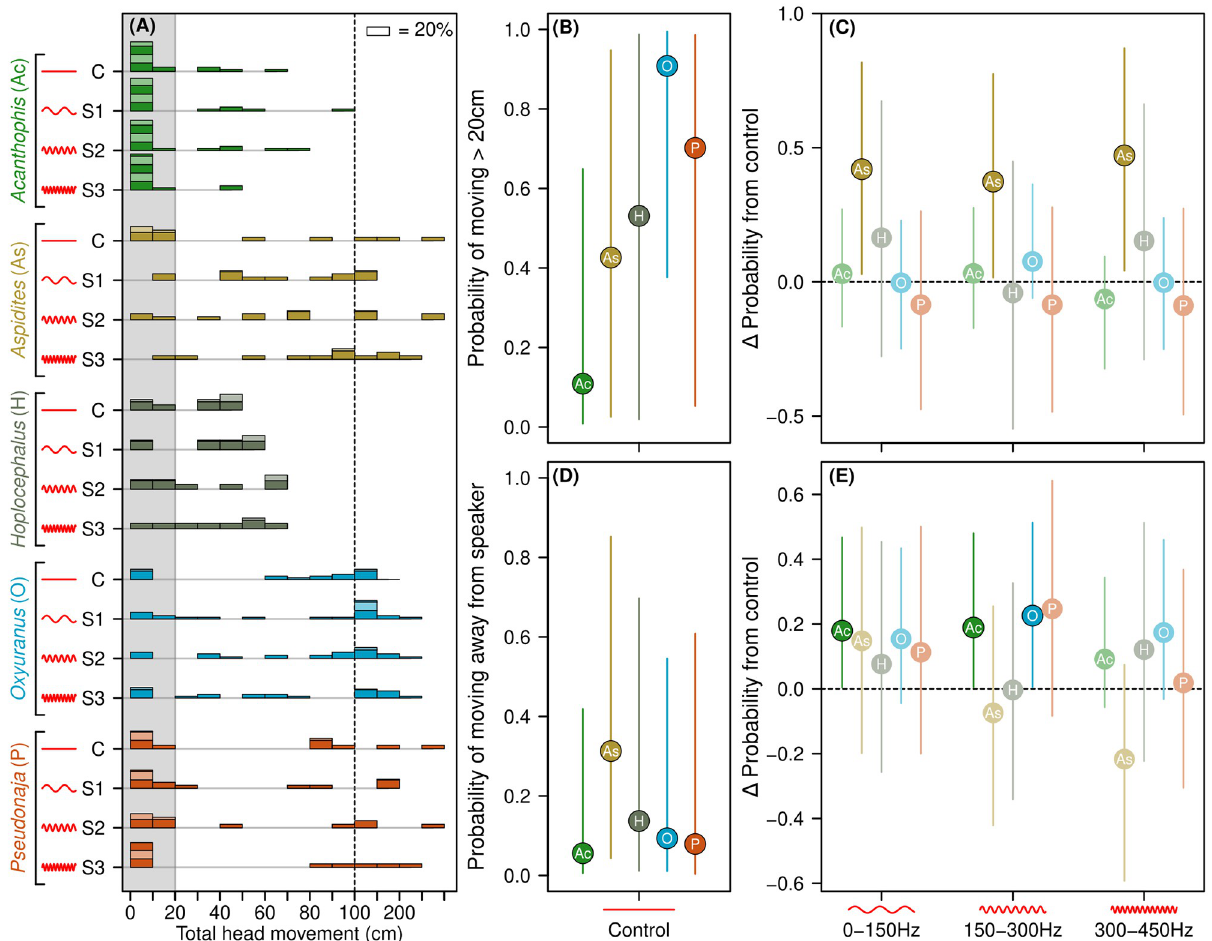
Fig 4. Snake movement in response to sound compared to controls. (A) Histogram of snake movement by genus (colored groupings) and sound treatment (C, S1-S3) (n = 4 per treatment per snake). Histogram bars are grouped in units of 10cm, except above 100cm (right of dashed line) where they are grouped in units of 50cm. Alternating colors on bars represent blocks of up to 20% of trials. Grey shading indicates the cut-off used to distinguish 20cm threshold for binary movement response used in probability model. (B ) Mean probability of > 20cm snake movement in control (n = 4 per snake). (C) Change in probability of movement from the control to each of three sound treatments. Values above zero (dashed line) indicate increase in probability, and vice versa. (D) Mean probability of movement away from speaker for each genus in control trials, using only snakes with > 20cm of movement. (E) Change in probability of movement away from speaker compared to control means for each of three sound treatments, as per (B). Lines in (B-E) represent 95% credible intervals from Bayesian hierarchical models. Points in C and E with 95% credible intervals that do not cross zero are highlighted as significant